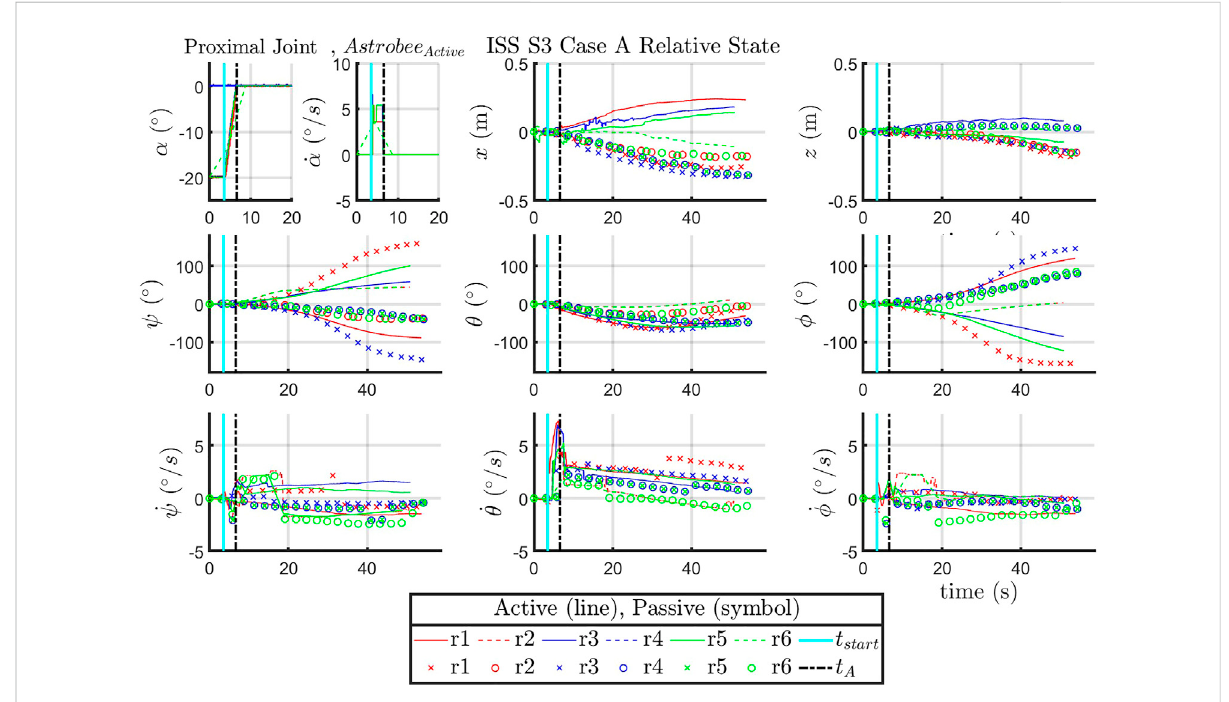
FIGURE A1 ISS: State data collected case A.